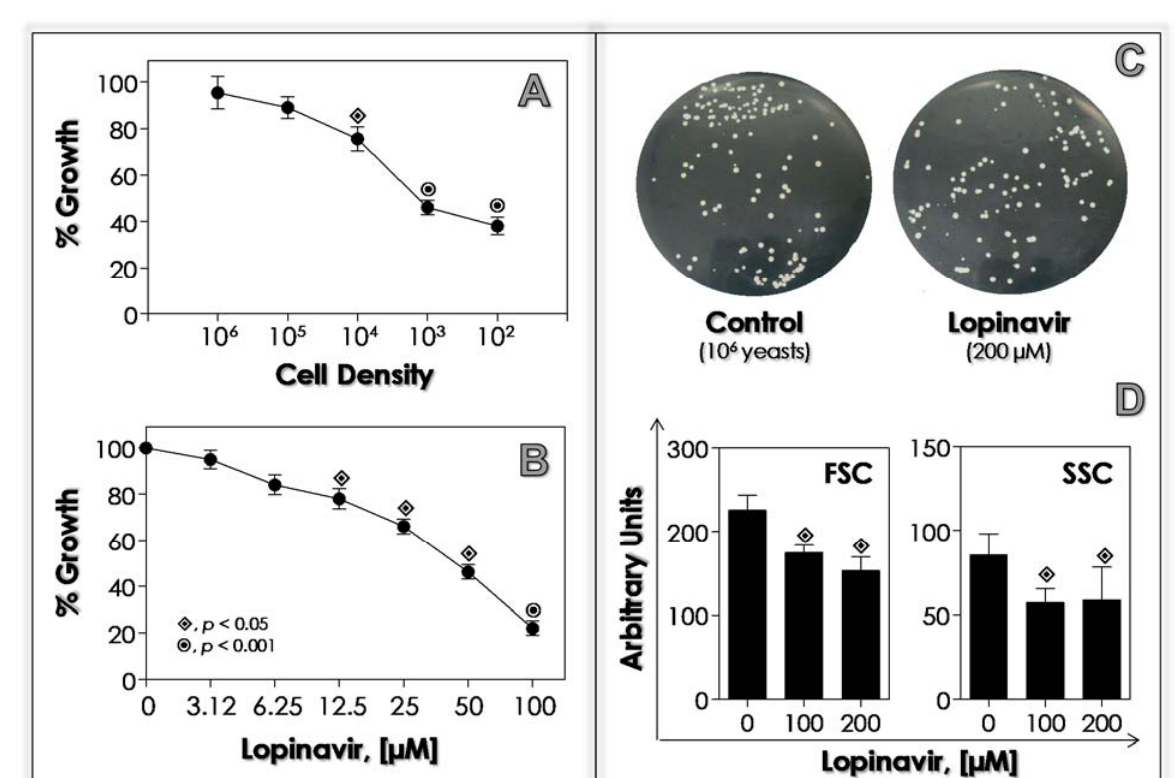
Figure 2. Effects of lopinavir on the growth of C. albicans yeast cells. ( A ) Different fungal densities (10 2 –10 6 yeasts) were treated with lopinavir at 50 µM. ( B ) Yeasts (10 3 cells) were treated with different concentrations of lopinavir (0–100 µM). In both set of experiments, the yeasts were incubated for 20 h at 37 °C with slight agitation. A control was made replacing lopinavir with PBS, which was considered as 100% of growth. Inhibition ratio was determined by CFU measurements. ( C ) The representative plates demonstrate the treatment of high cellular density (10 6 yeasts) with lopinavir at 200 µM for 20 h, revealing a similar growth rate in comparison to the untreated ones. ( D ) In parallel, 10 6 yeasts were treated (or not) with lopinavir (at both 100 and 200 µM) for 20 h and then analyzed by flow cytometry in order to measure size and granularity. Forward scatter (FSC) measurement is related to cell size, and side scatter (SSC) measurement is related to the internal granularity and/or complexity of a cell. In all cases, the values represent the mean ± standard deviation of three independ- ent experiments performed in triplicate. The symbols indicate the experimental systems considered statistically significant from the control (Student’s t -test).